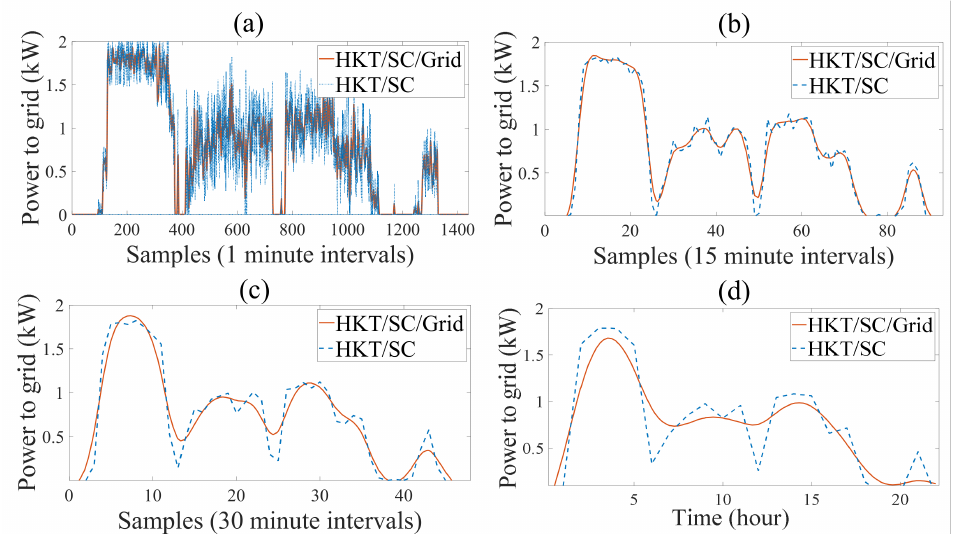
Figure 10. Electricity surplus peaks smoothed and sent to the grid. Data sampling at different time intervals: ( a ) 1 min, ( b ) 15 min, ( c ) 30 min and ( d ) every